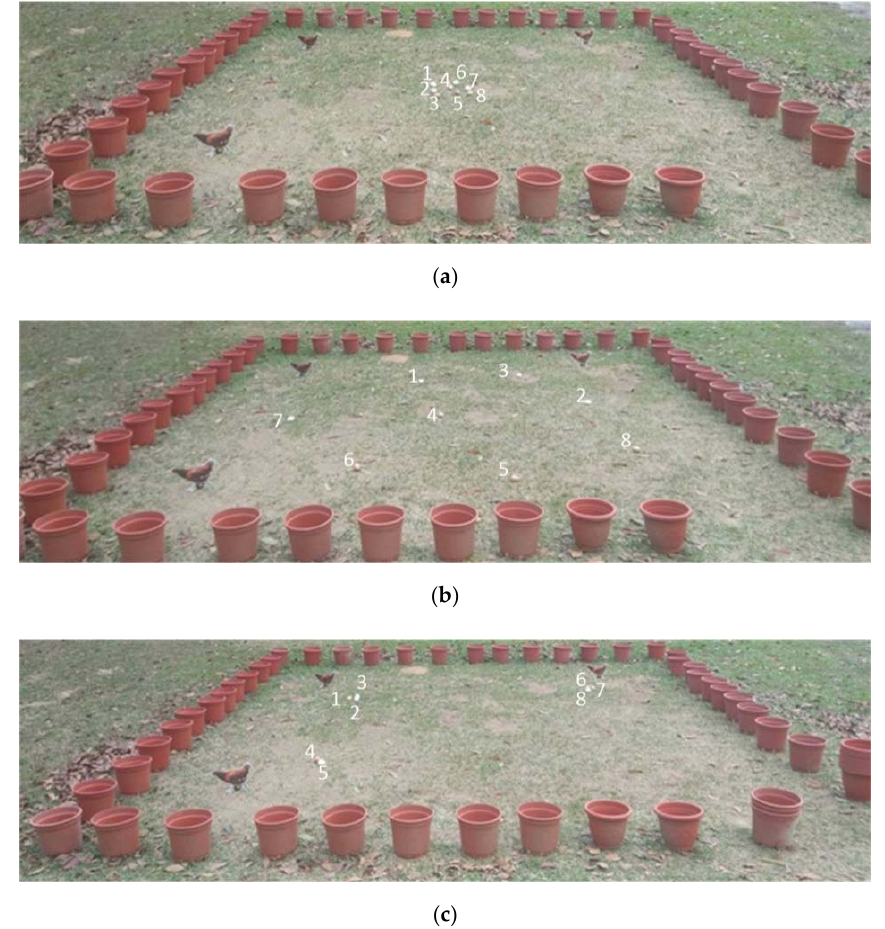
Figure 13. Configurations of eggs in the field: ( a ) central; ( b ) corner; ( c ) dispersed.